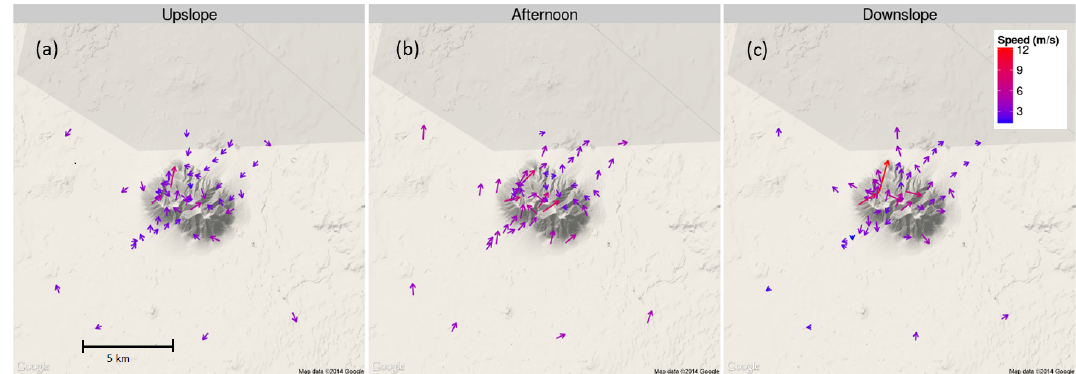
Figure 5. Average flow during (a) upslope (11:00 LT), (b) afternoon (16:00 LT), and (c) downslope (00:00 LT) flow regimes at Big Southern Butte during periods of weak synoptic flow between June and September 2010. Vectors represent the average hourly flow at a given sensor. Vectors are centered on sensor locations. Periods of strong synoptic forcing were removed prior to averaging. Table 3. Measured wind speeds (ms − 1 ) during upslope, downslope, and convective mixing regimes at Big Southern Butte (BSB) and Salmon River Canyon (SRC). Decoupled ridgetop locations (sensors R26, R35, TSW7, and R15) were omitted from BSB averages; speeds in parentheses include ridgetop sensors. Times are local. Site Wind speed Upslope (11:00) Afternoon